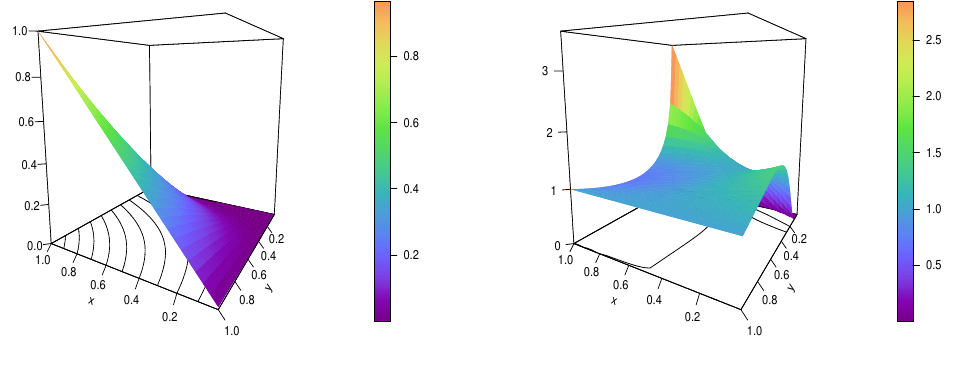
Figure 9. Plots of the Int2 copula ( left ) and the Int2 copula density ( right ) for α = γ = 1.